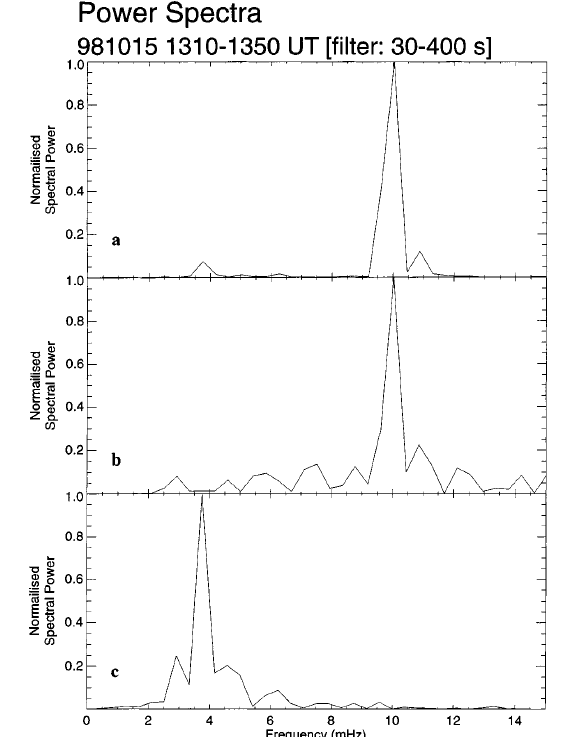
Fig. 2. Normalised power spectra for the interval 1310–1350 UT of the time series plotted in Fig. 1. a CUTLASS Finland beam 5, range 30, b DOPE and c TRO X-component. All data were filtered in the range 30–400 s before being passed through the fast Fourier